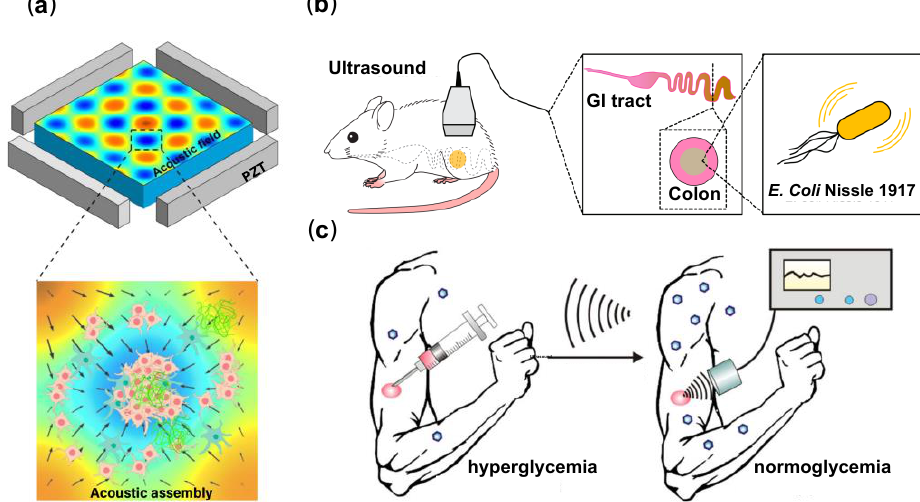
Figure 5. Schematic illustration of the applications of acoustic micro/nanoparticles ( a ) Acoustic as- sembly process of three-dimensional neurospheres [144] (Reproduced with permission from Cai et al., Analyst; published by Royal Society of Chemistry, 2020); ( b ) Experimental diagram of gastrointestinal tract imaging [145] (Reproduced with permission from Bourdeau et al., Nature; published by Nature Portfolio, 2018); ( c ) Schematic representation of long-term drug delivery after subcutaneous injection of nanocarriers [146] (Reproduced with permission from Di et al., Advanced Healthcare Materials; published by Wiley, 2014).